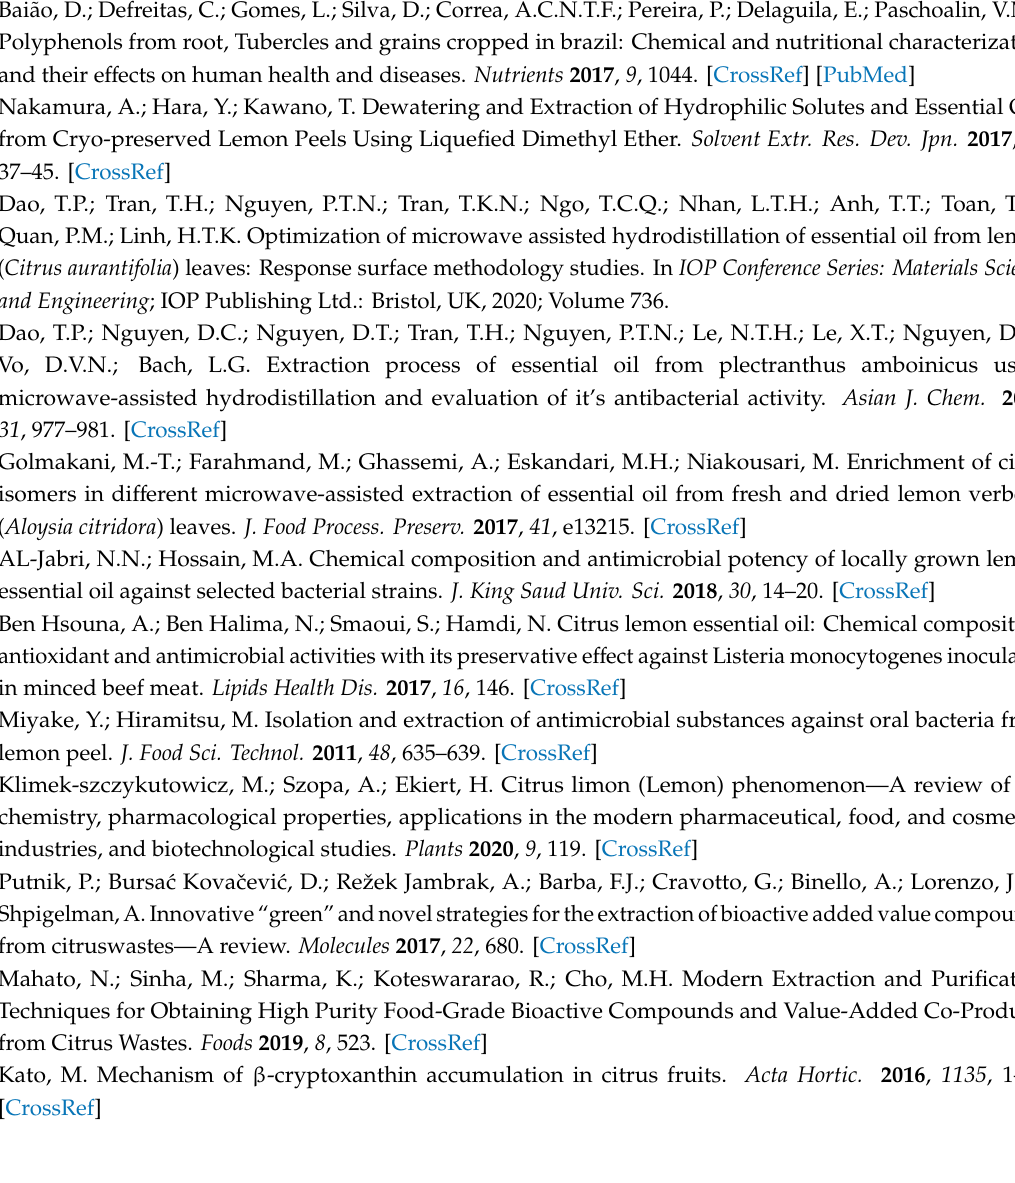
Table S1: BBD design matrix and response values obtained for LP extraction from lemon waste; Table S2: ANOVA results for response surface quadratic models of LP